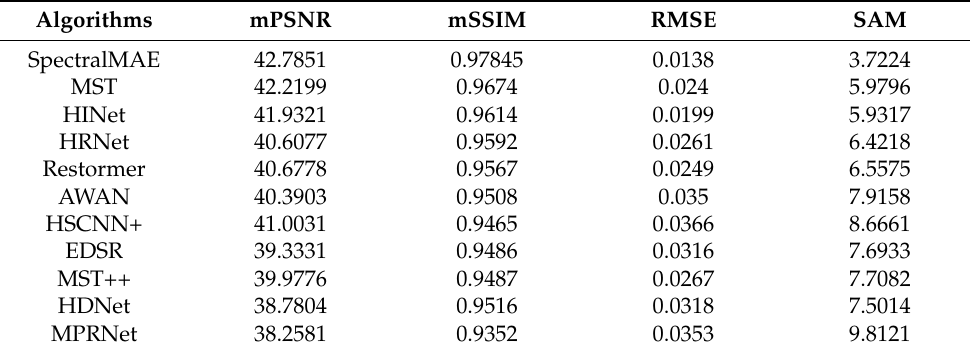
Table 2. Quantitative results on the HyRANK